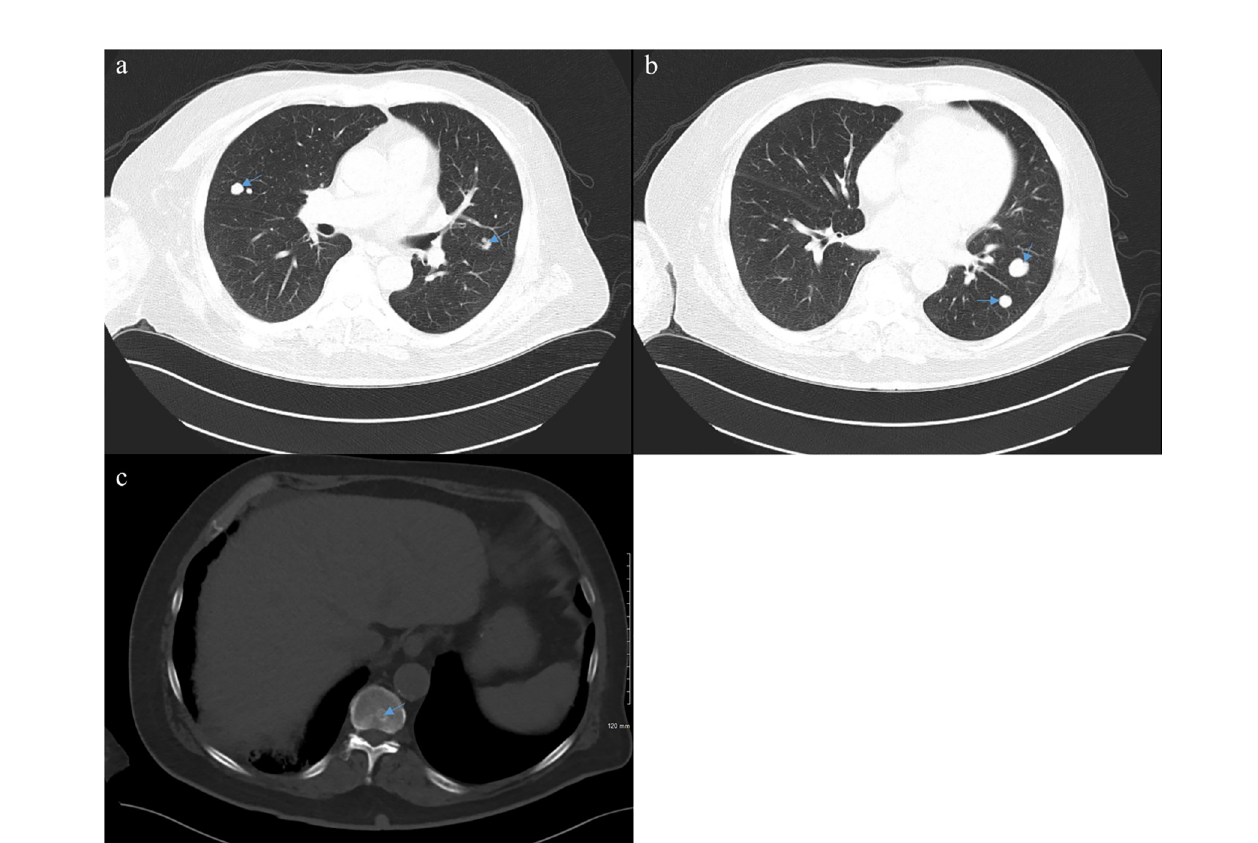
FIGURE 1 | Computed tomography (CT) of the chest, abdomen, and pelvis from April 2021 demonstrating bilateral pulmonary nodules (A, B) and an L2 lesion (C) consistent with metastatic